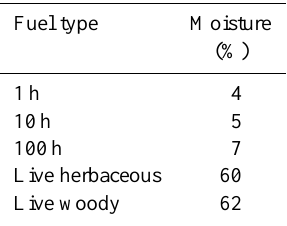
Table 1. Fuel moisture values used in the wildfire simulations. Parameters obtained from fire management and silviculture special- ists, Lakeview Ranger District, Fremont-Winema National